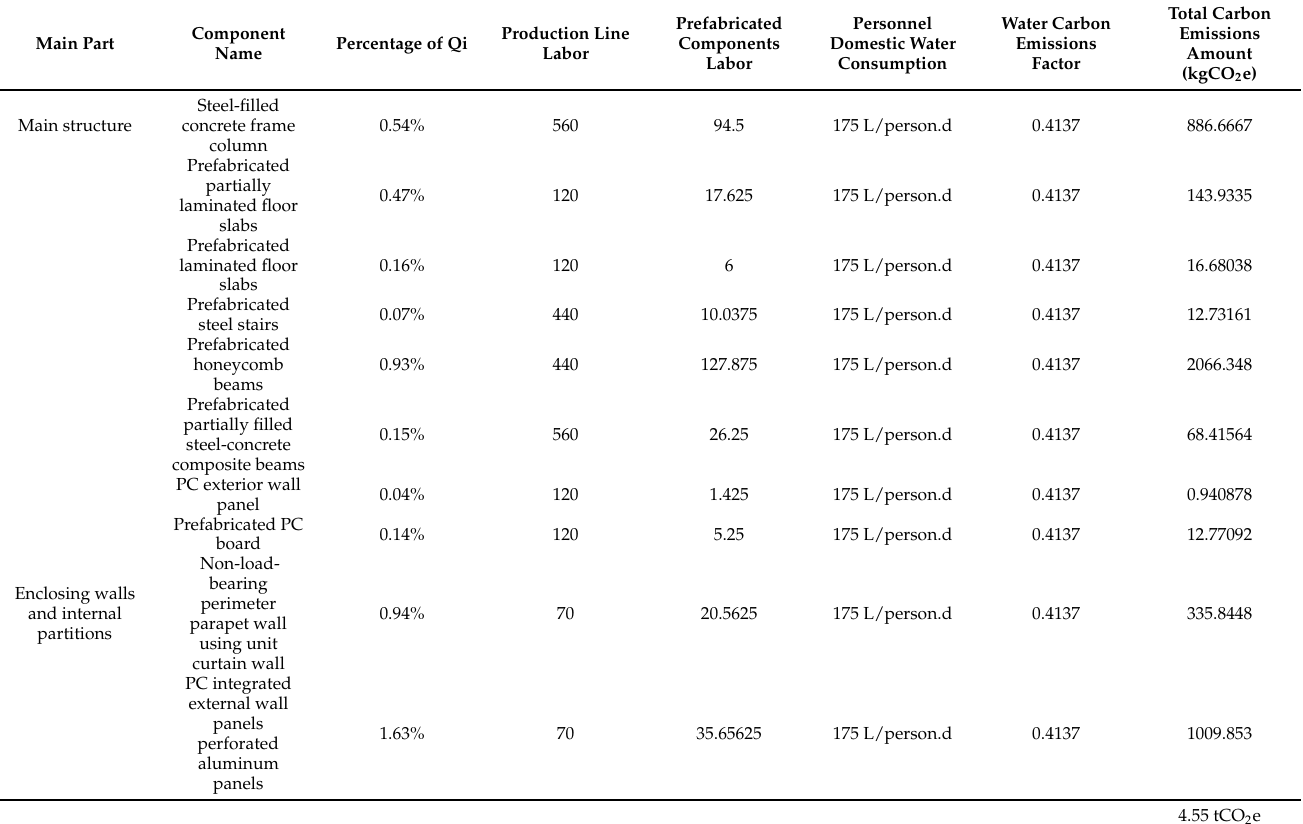
Table 10. Carbon emissions of W p i